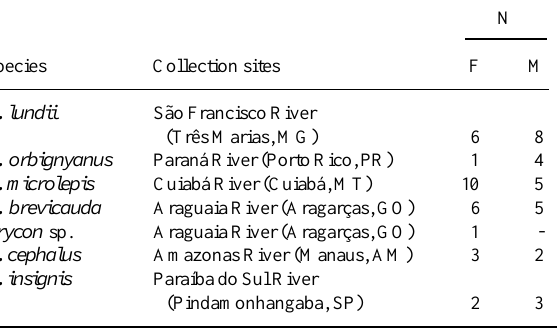
Table I - Species of the genus Brycon and collection